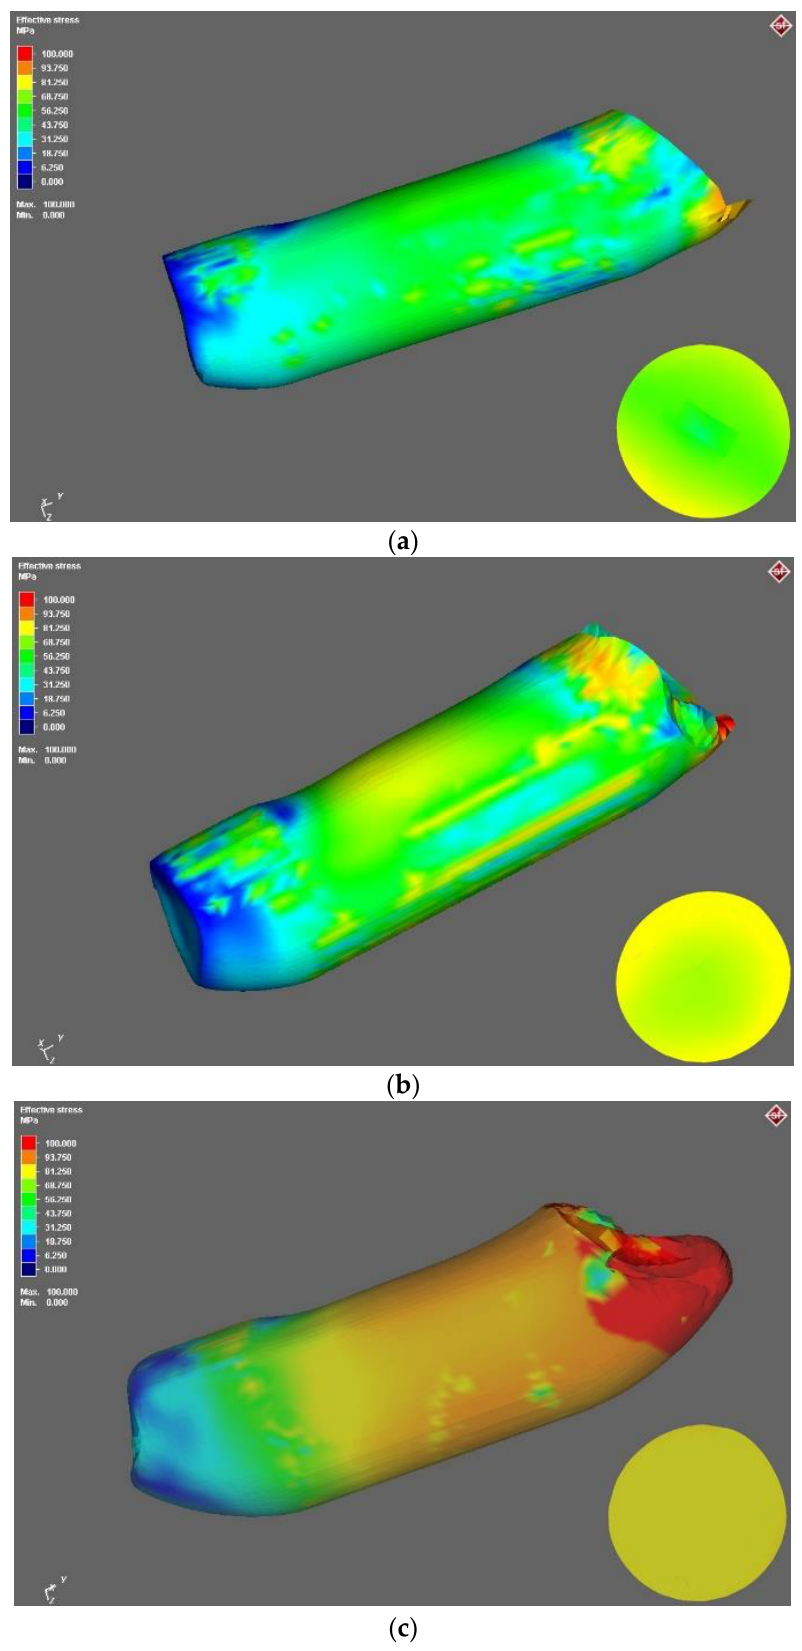
Figure 6. Stress distribution along both the LS and TS of the ECAPed AA2011 samples processed through 1- p ( a ), 2-Bc ( b ) and 4-Bc ( c ) at 150 ◦